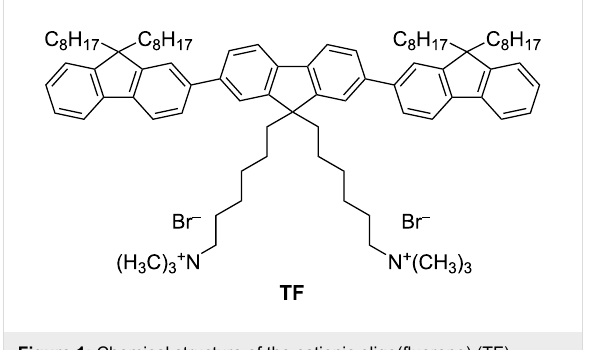
Figure 1: Chemical structure of the cationic oligo(fluorene)